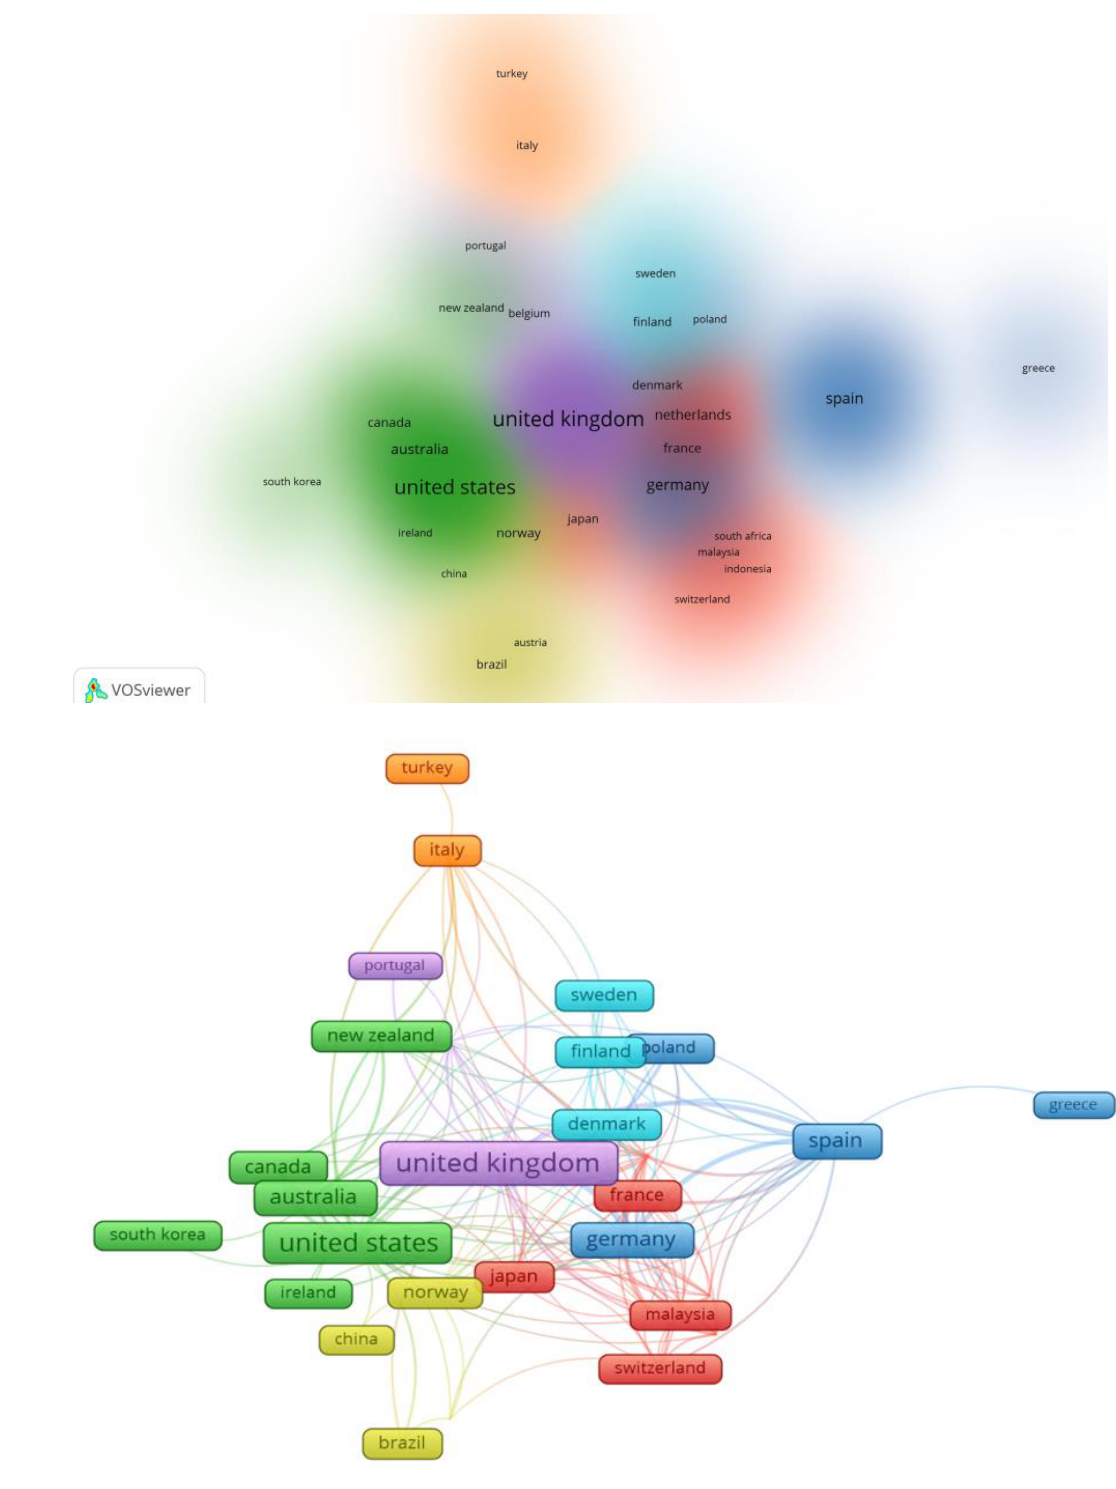
Figure 8. Most productive countries in environmental valuation research developed using VOSviewer, showing ( a ) the density visualization and ( b ) mapped network visualization.